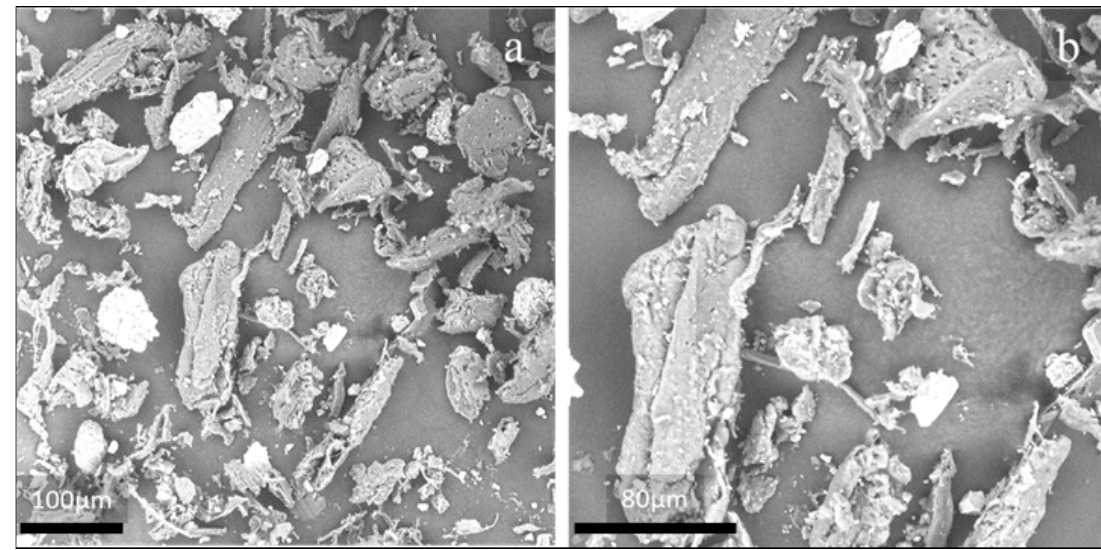
Figure 5. SEM micrographs of OFI fibers before processing, at 500× ( a ) and 1000× ( b ) magnification.